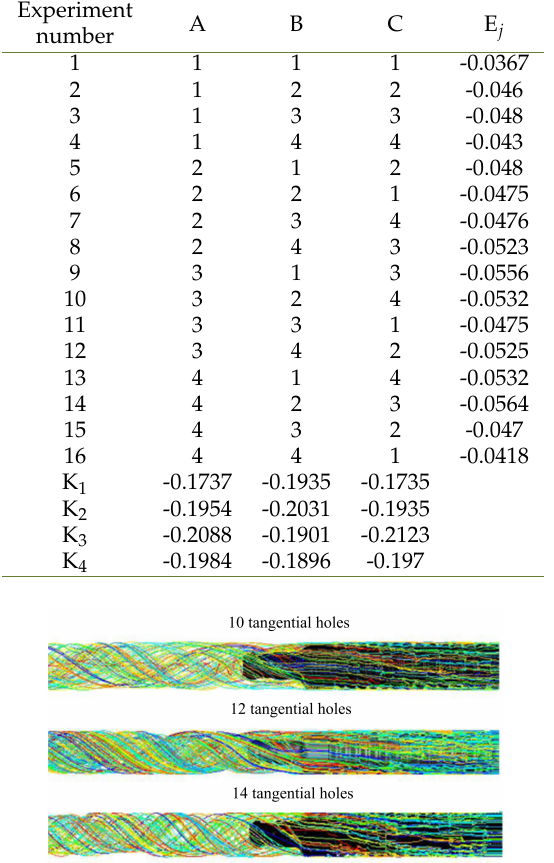
Fig. 13. Streamline of different number of tangential holes flowing through plunger.